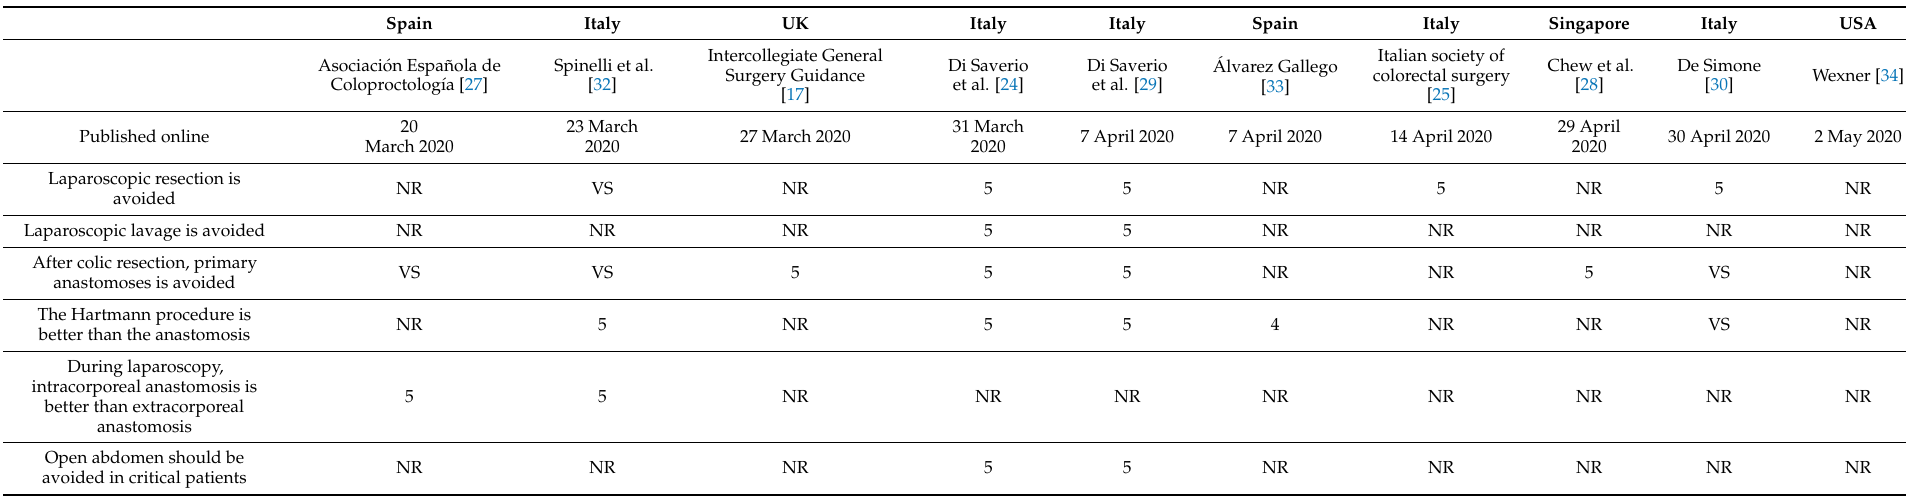
Table 3. Difference of procedures.